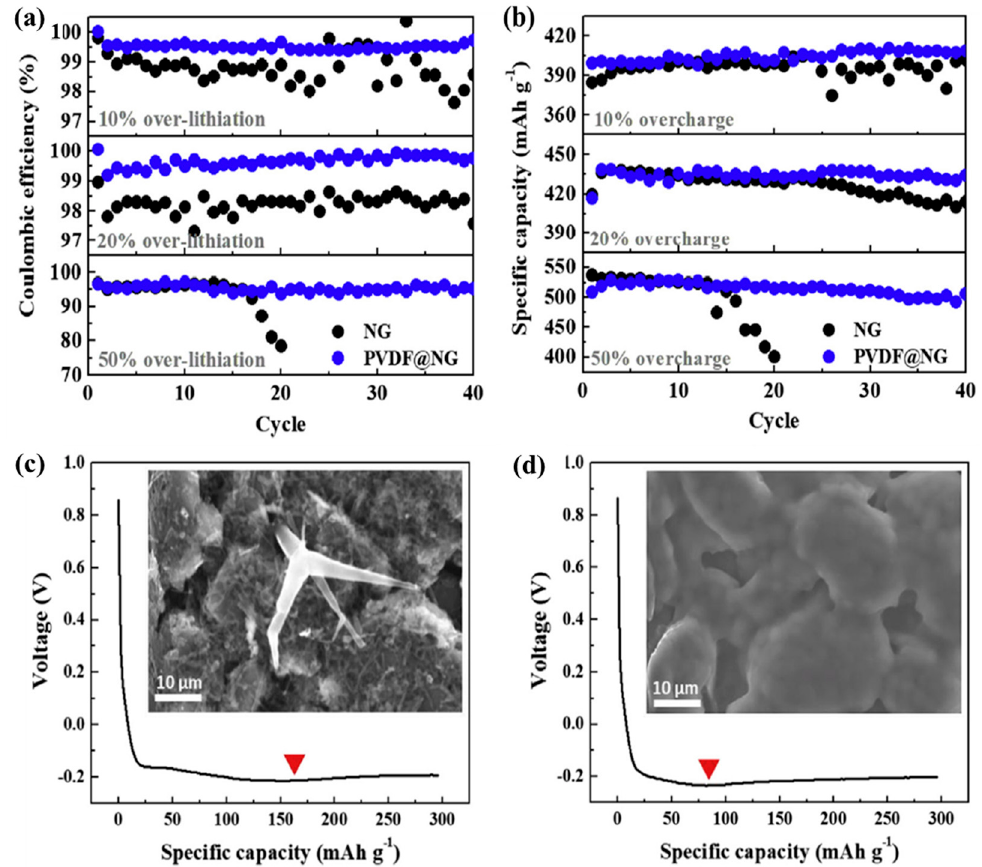
Figure 5. ( a ) CE and ( b ) specific capacity during cycling with various extents of over-lithiation. The coated Gr electrode displayed significantly enhanced cycling stability with high Coulombic efficiencies under the Li-plating conditions. SEM images and corresponding voltage profiles of ( c ) natural Gr electrode and ( d ) PVDF@ natural Gr electrodes under high-rate charging at 10 C for 48 min. Three formation cycles at 0.1 C considering 0.0–1.5 V vs. Li/Li + . Additional charging for 30, 60, and 150 min at 0.2 C after the cell voltage reached 0.0 V was used to compel over-lithiation cycling, corresponding to 10%, 20%, and 50% of theoretical capacity, respectively. Electrolyte: 1 M LiPF 6 in a 1:2 ( v / v ) mixture of EC/EMC) with 2 wt.% vinylene carbonate (VC) additive. 1 C = 372 mA g − 1 . Reproduced from Ref [12] with permission from Elsevier.